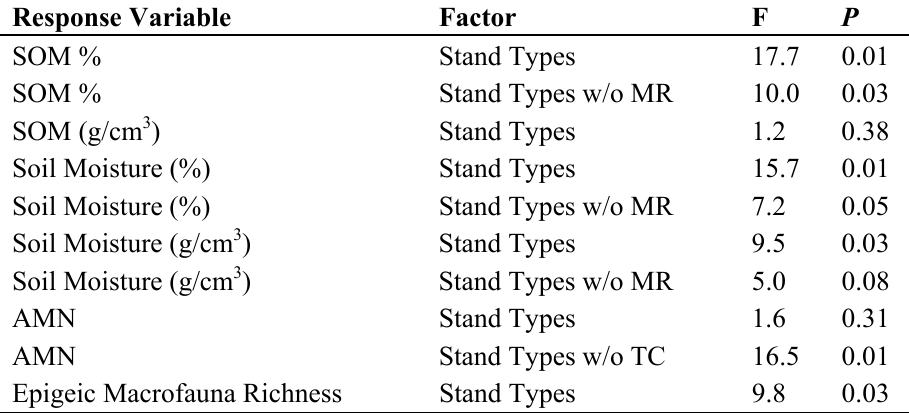
Table 2. Summary of ANCOVA results. df = 2, 4 in all cases. SOM = soil organic